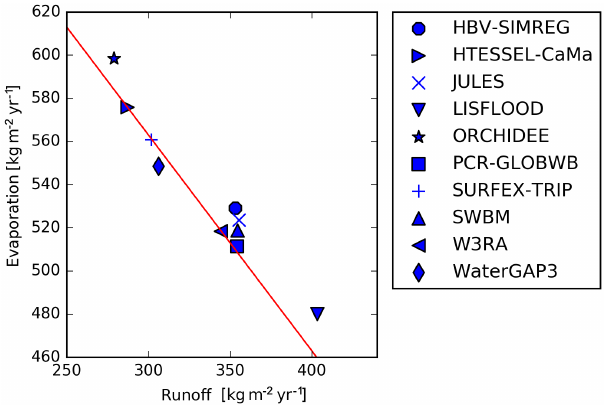
Figure 10. Average runoff plotted against average total evaporation (both expressed in kgm 2 yr − 1 ) for all models. The solid line rep- resents the input precipitation minus runoff. For this line we used 863kgm − 2 yr − 1 , which is the average calculated over all grid cells that have values for each